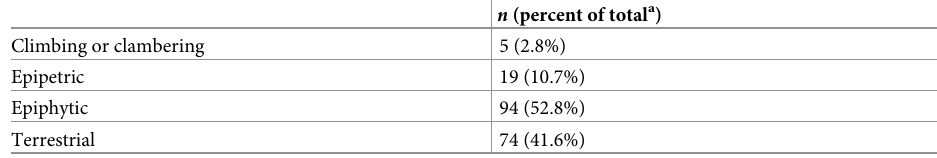
n (percent of total a )